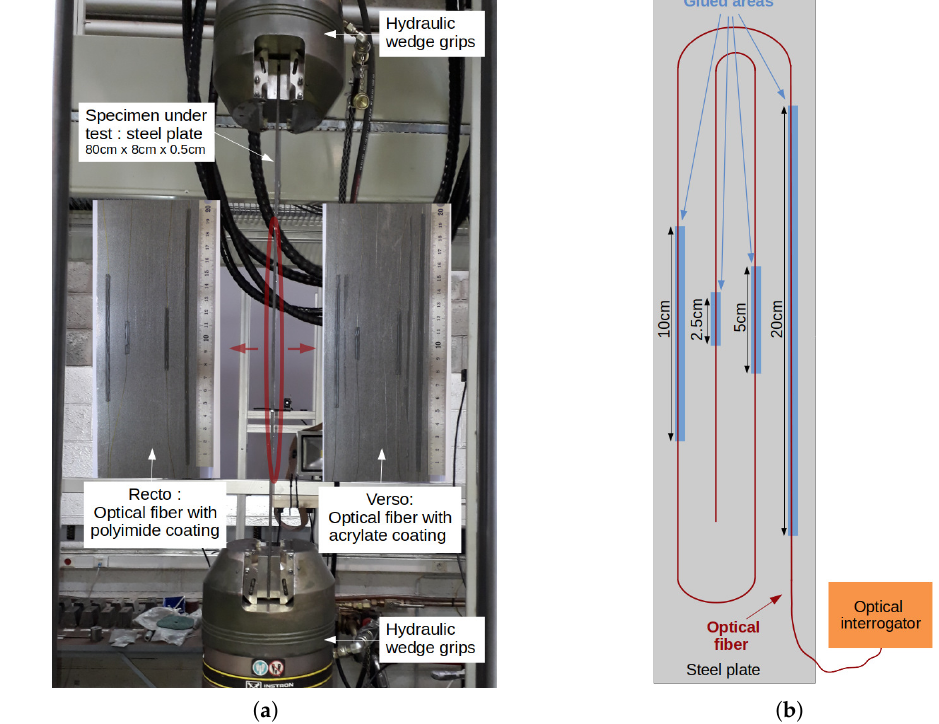
Figure 7. Experiment description of uniform strain field measurements. ( a ) Photography of the in- strumented specimen under tensile test. ( b ) Schematic presentation of the specimen